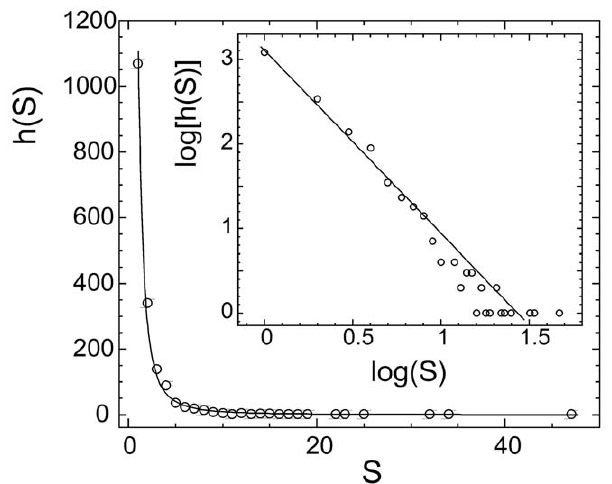
Figure 2 . Histogram of complex structural clusters versus size of the clusters. The solid curve is the fitting result from Eq. 12. Inset: the same data drawn in logarithm scale.